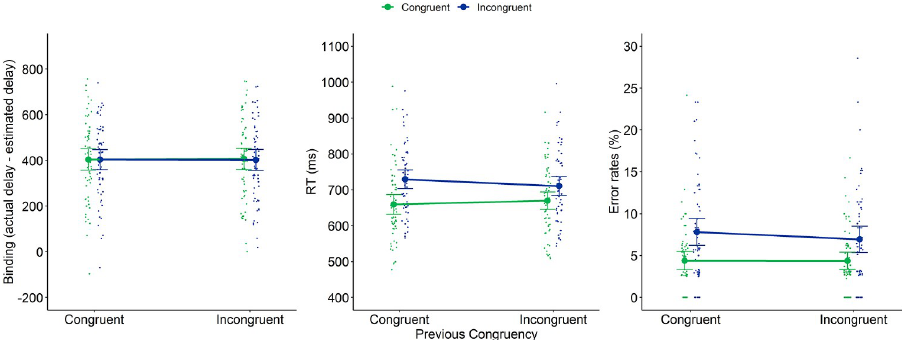
Fig 3. Intentional binding (left panel), RTs (middle panel) and error rates (right panel) of Experiment 1 as a function of Block and current congruency. Dots represent mean RTs for each participant in each condition (thus, each participant is depicted four times on this graph, once for each Block × Current Congruency condition). Error bars represent 95% confidence intervals.